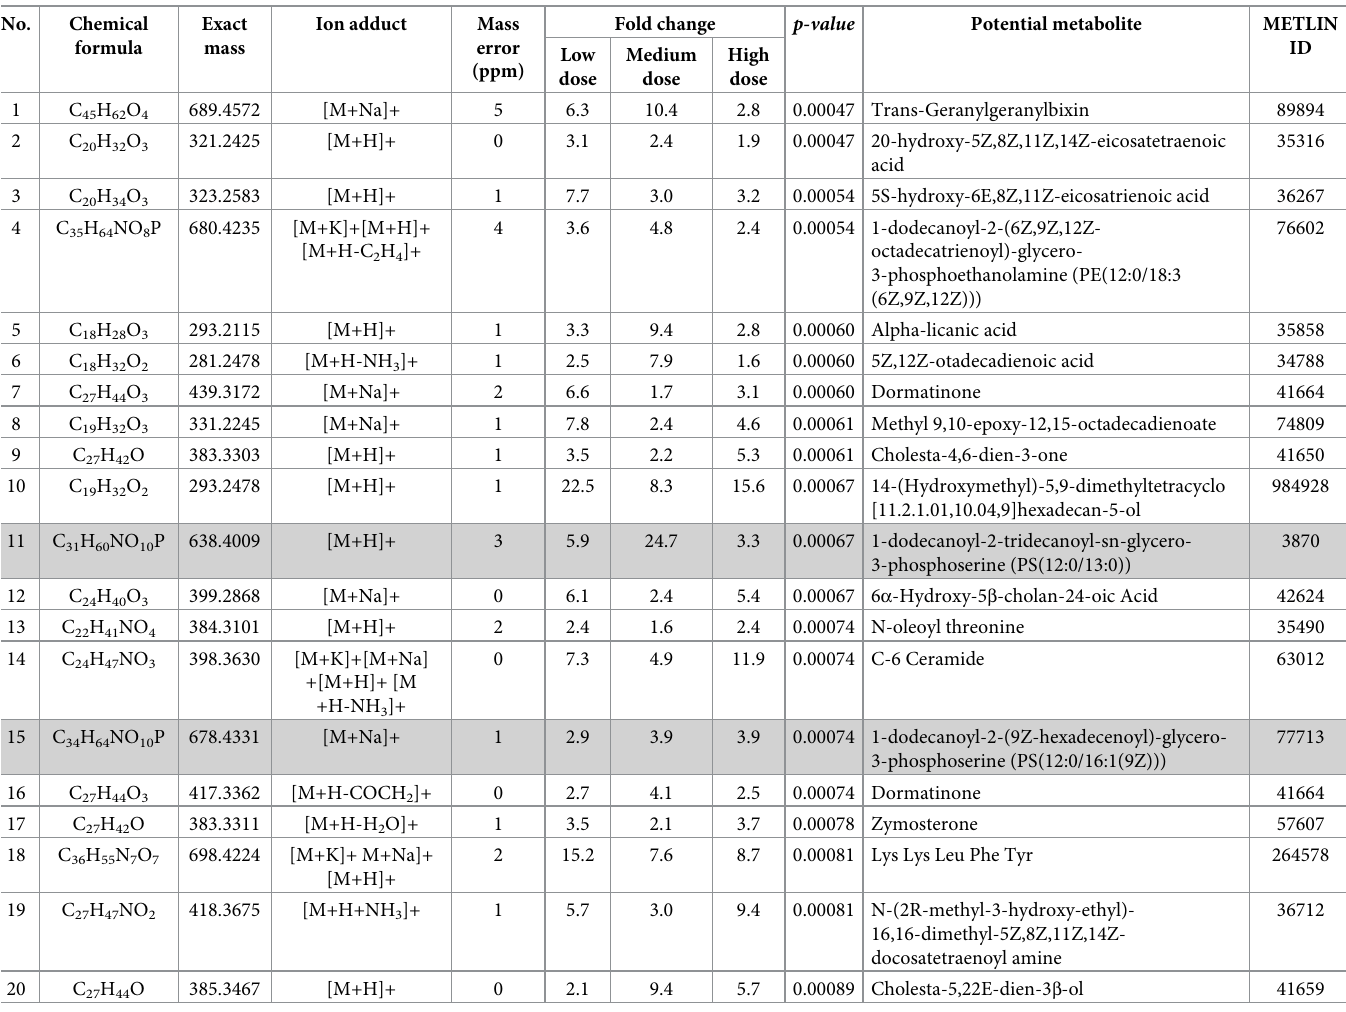
Table 1. Top 20 metabolites of S . mekongi with increased level after PZQ treatment by multivariate analysis.